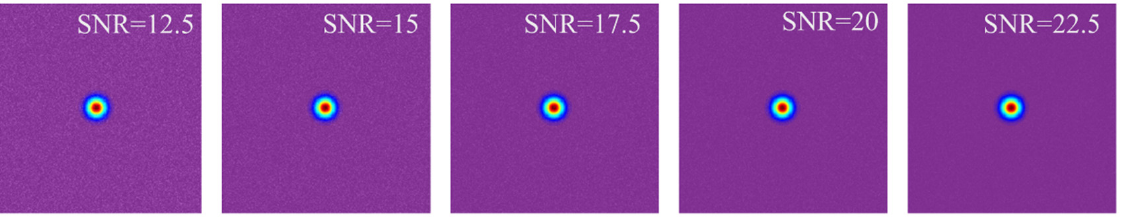
Figure 6. Laser spot after adding noise with different SNRs.